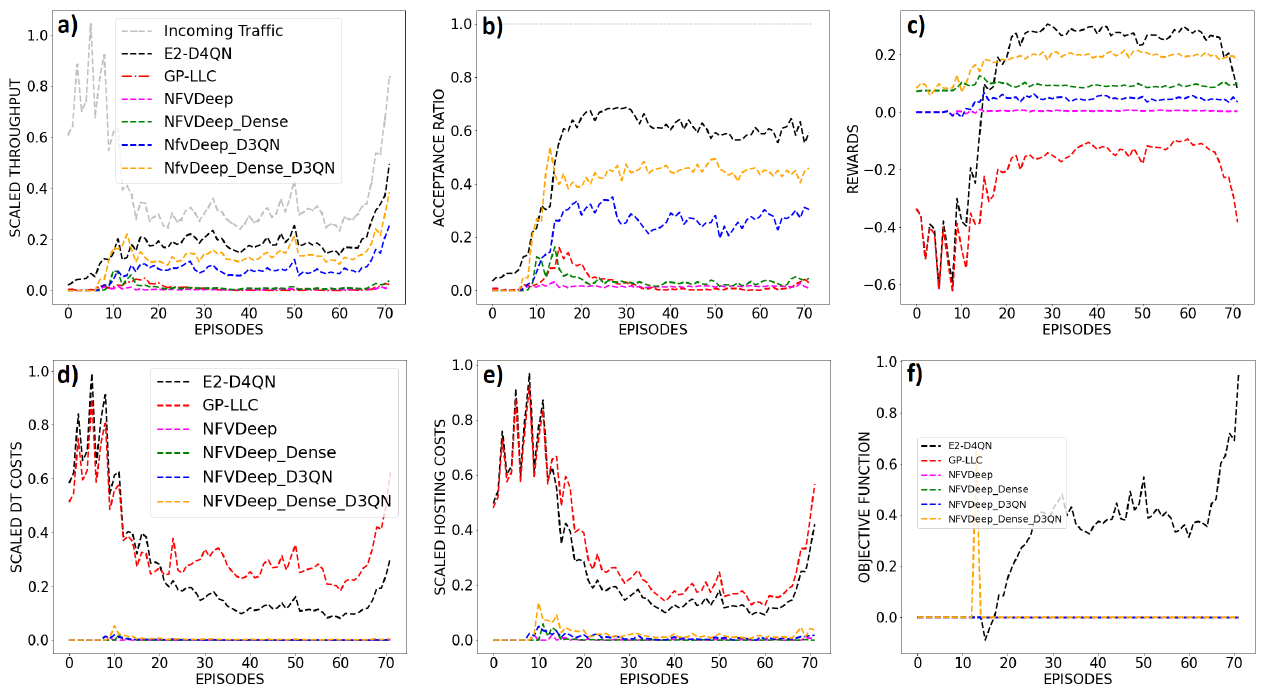
Figure 3. Basic evaluation metrics of E2-D4QN , GP-LLC , NFVDeep and three variants of the latter, presented in Section 2.3.4. ( a ) Scaled mean network throughput per episode. ( b ) Mean Acceptance Ratio per episode. ( c ) Mean rewards per episode. ( d ) Mean scaled total Data-Transportation Costs per episode ( e ) Mean scaled total hosting costs per episode. ( f ) Mean scaled optimization objective per